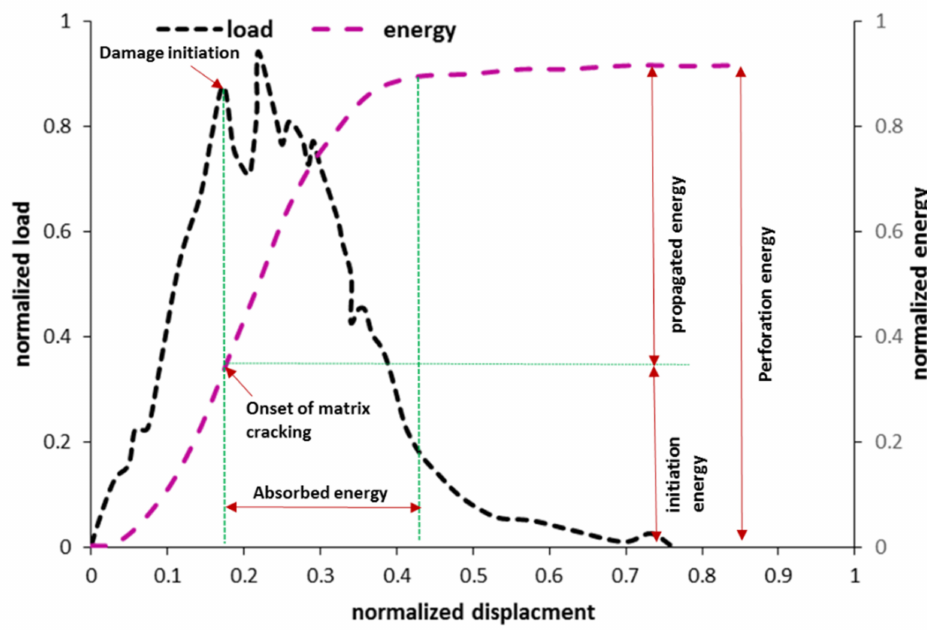
Figure 6. A typical plot of the load-displacement and energy-displacement curves for general FRP composites under impact